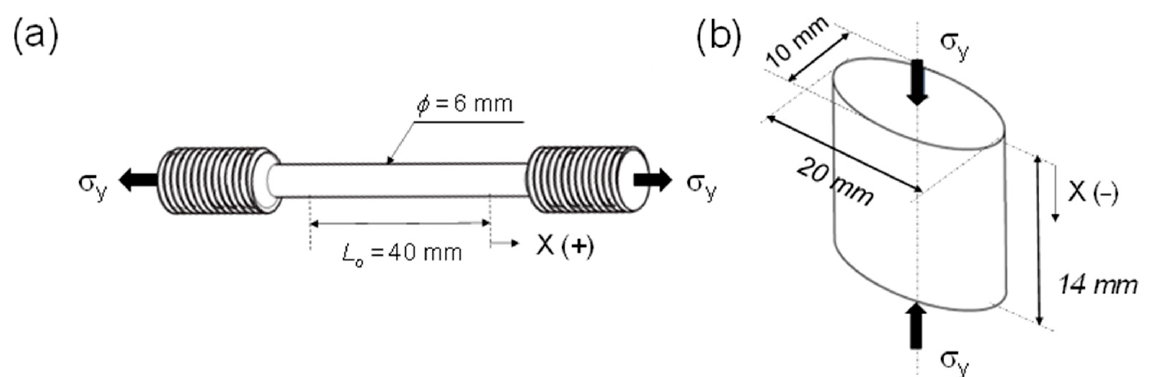
Figure 2. Schematic representation of the different specimens used in the macroscopic tests. ( a ) Tensile and ( b ) compression specimens. σ y and X denote the direction of the stress and the displacement associated with the tensile and compressive loadings. The positive and negative signs of the displacements correspond to the lengthening and shortening of the gauge length, respec- tively.